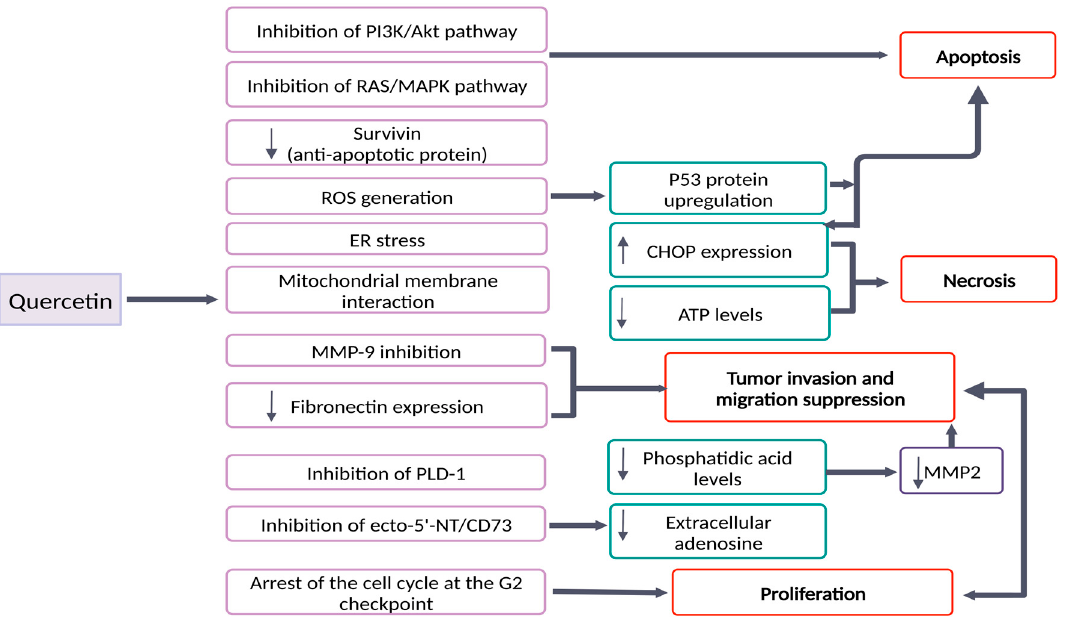
Figure 2. Some of the possible targets that are related to quercetin anticancer activity; (created with www.biorender.com; 2 March 2023); ↑ Increase; ↓ Decrease.